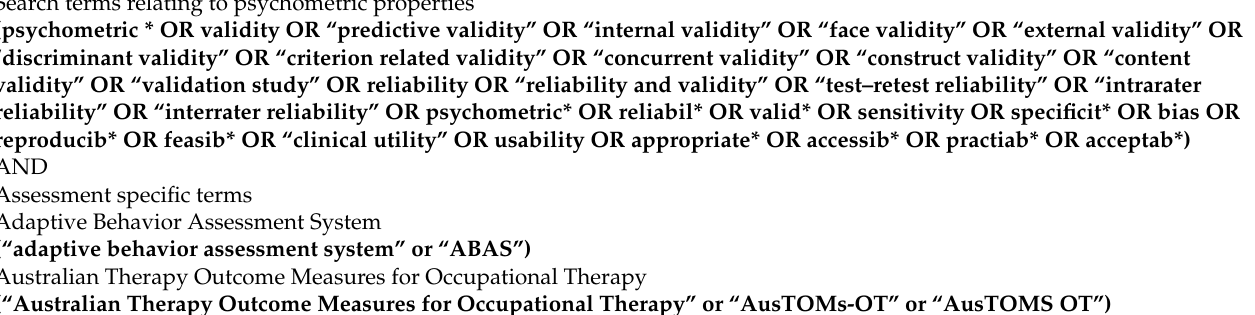
Table A1. Search Terms Used to Identify Relevant